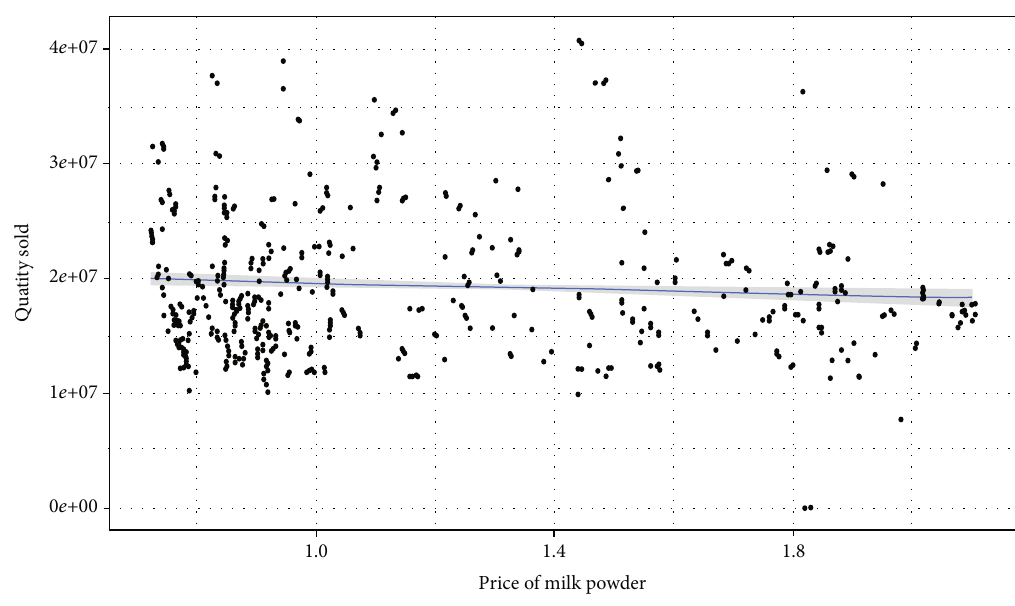
Figure 4: Milk powder demand function.